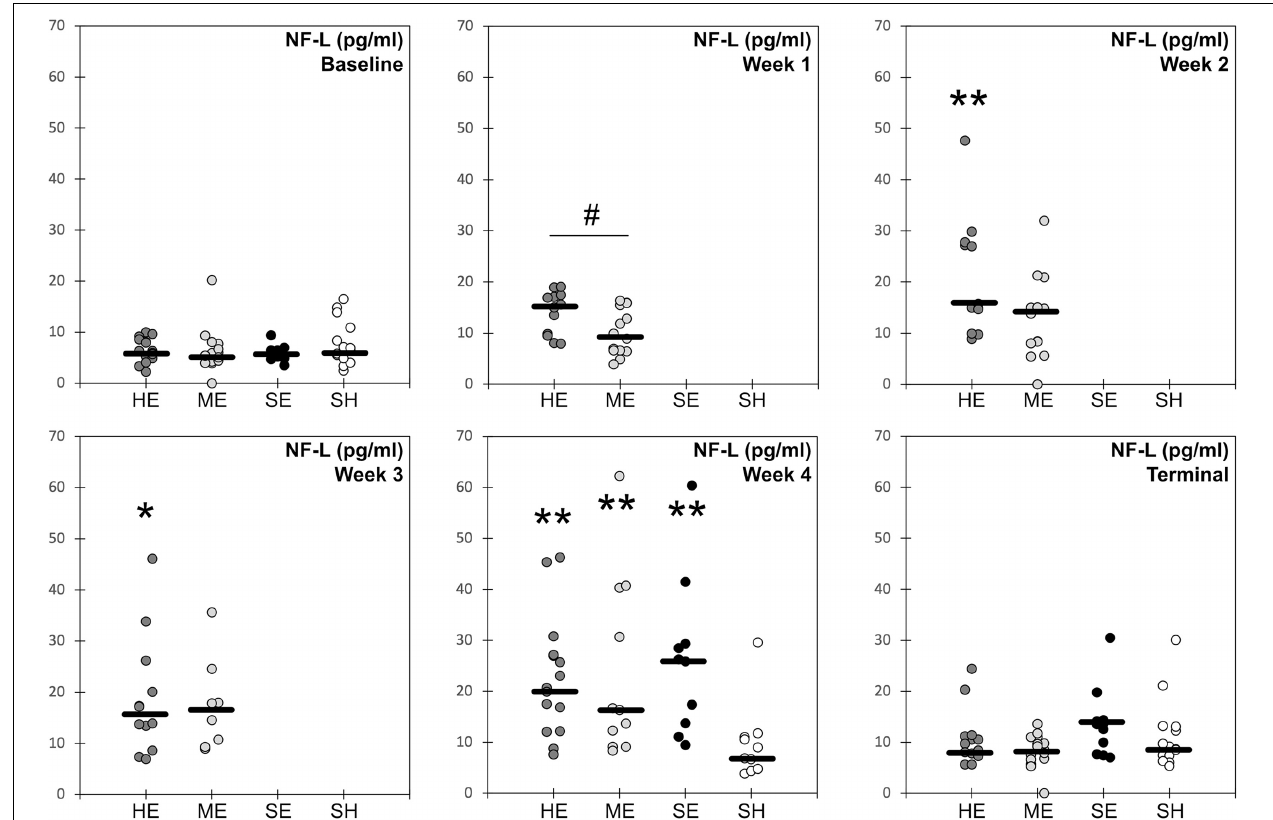
FIGURE 3 | Blood serum concentration levels of neurofilament light protein for each of the four experimental groups (HE, high exposure; ME, moderate exposure; SE, single exposure; SH, sham). Solid horizontal lines represent the median groupwise data at each timepoint. * indicates statistically significant groupwise elevation relative to the baseline level for that experimental group. ** indicates statistically significant groupwise elevation relative to the baseline and terminal levels for that experimental group. # indicates significant difference in NFL concentrations between high and moderate exposure groups at that time